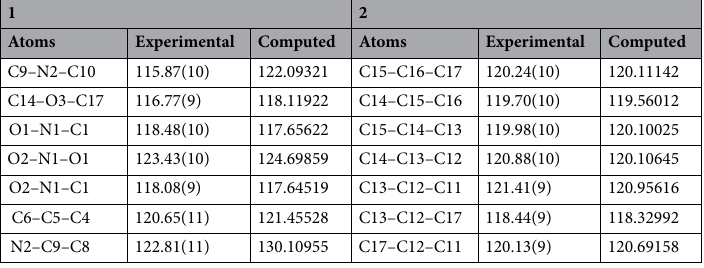
Table 3. Selected experimental and calculated bond angles (°) of 1 and 2